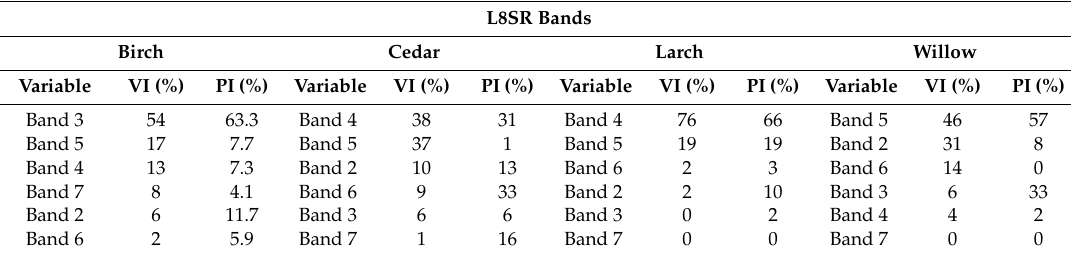
Table 2. Estimates of variable importance of the satellite imagery variables.